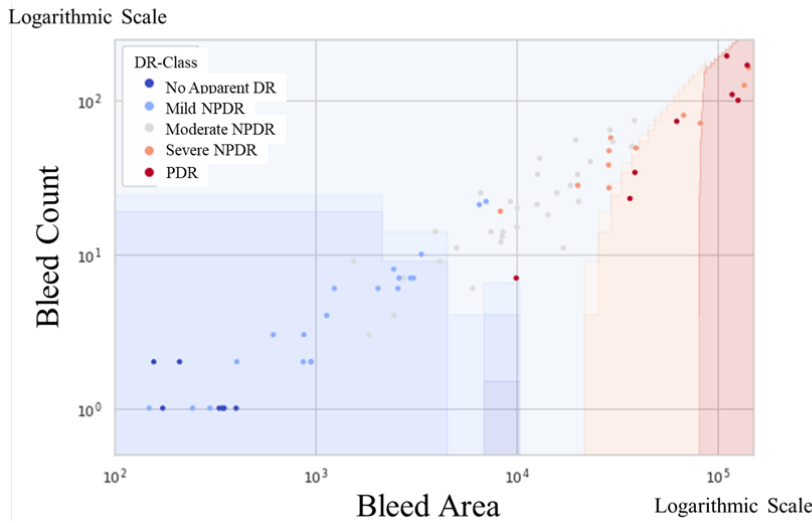
Figure 2. Scatter plots of hemorrhage count and area in the 87-eye dataset for building the SVM model. The SVM model estimated stage boundaries as color-coded maps. The hemorrhage count and area tended to increase as the disease became more severe.